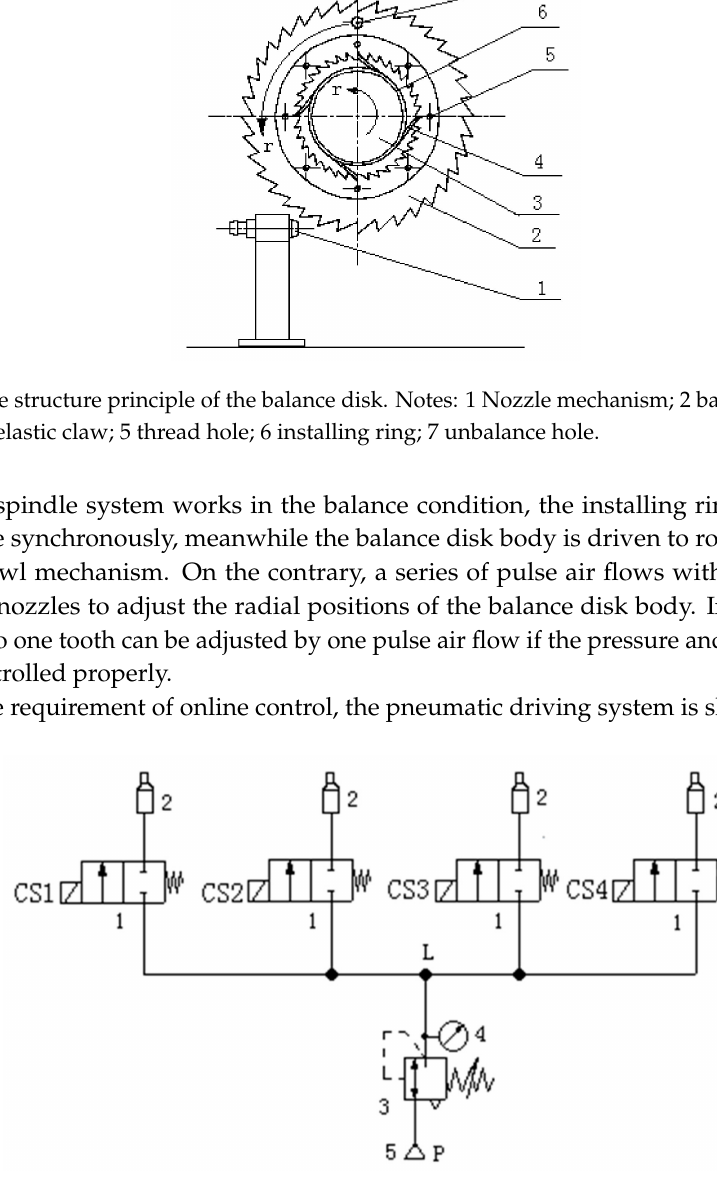
Figure 4. The pneumatic control system. Notes: 1 two-position two-way valve; 2 nozzle; 3 pressure regulating valve; 4 pressure gage; 5 air